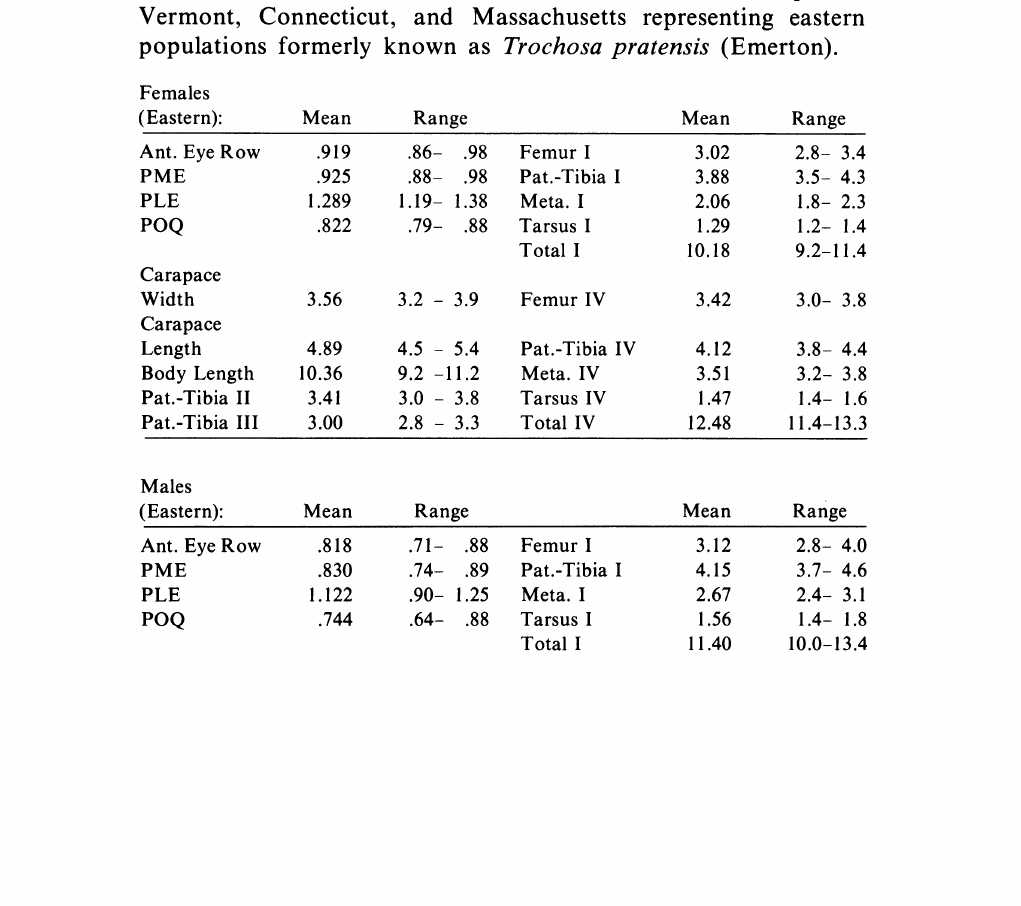
Sternum yellow to light brownish yellow. Color. Western Males. Face yellow to brownish yellow, lightest along lower edge of clypeus. Chelicerae orange to brownish orange. Eye nacelles black. Cymbium of palpus brownish yellow to light brown. Carapace yellow-brown, with broad pale yellow median stripe enclosing pair of darker stripes in the cephalic region; with lighter pale yellow submarginal stripes. Dorsum of abdomen pale yellow to light yellow-brown with darker brown or black spots that sometimes coalesce to form pat- tern. Cardiac area uniformly brown with slight reddish tinge. Venter pale brownish yellow to cream without darker markings. Legs light brownish yellow to yellow dorsally, pale yellow to cream ventrally. Distal segments darker. Labium and endites yellow-brown with distal ends yellow to cream. Sternum